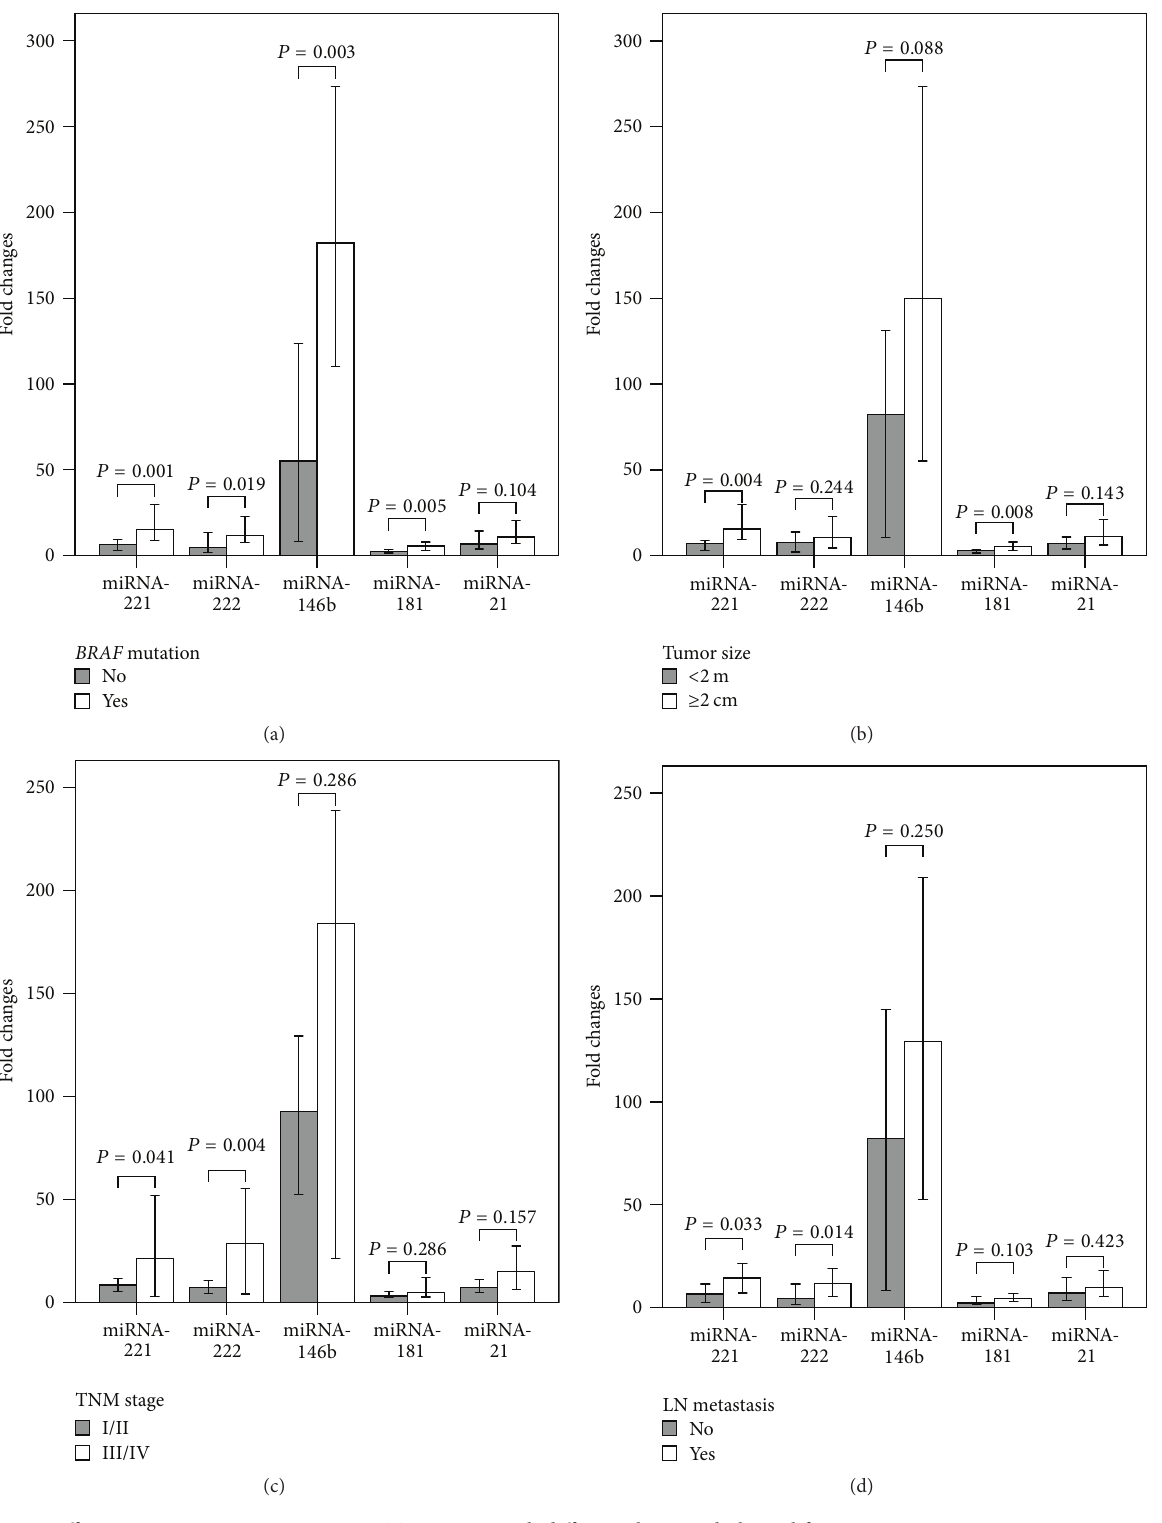
Figure 3: Differences in miRNA expression in PTC patients with different clinicopathological features. miRNA-221, miRNA-222, miRNA- 146b, and miRNA-181 expression levels were significantly higher in BRAF mutation group than in non- BRAF mutation group ( 𝑃 < 0.05 for all comparisons). miRNA-21 expression level was not significantly different between the two groups ( 𝑃 = 0.104 ) (a). The levels of miRNA- 221 and miRNA-181 were significantly higher in patients with tumor diameter ≥ 2 cm than < 2cm ( 𝑃 = 0.008 and 𝑃 = 0.004 , resp.) (b). The overexpression of miRNA-221 and miRNA-222 was found in patients with advanced TNM stage ( 𝑃 = 0.004 and 𝑃 = 0.041 , resp.) (c) and lymph node metastasis ( 𝑃 = 0.033 and 𝑃 = 0.014 , resp.) (d). Statistically significant differences were determined by the Mann-Whitney 𝑈